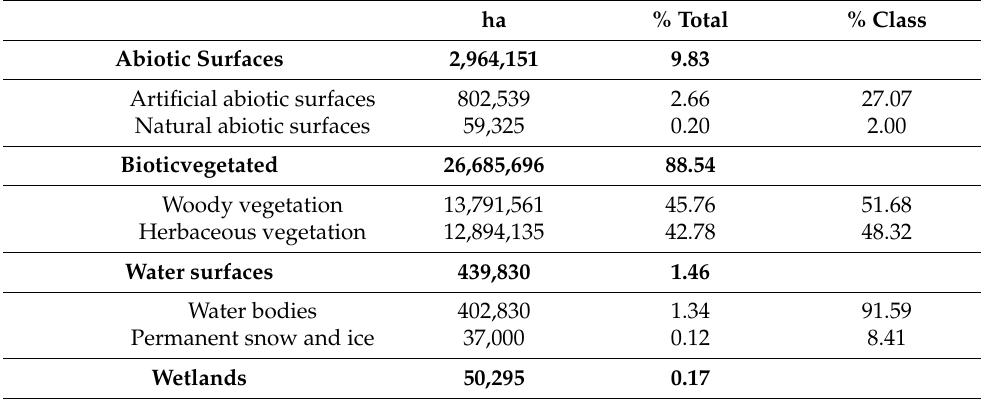
Table 11. Land cover classes 2012 (first and second classification level).